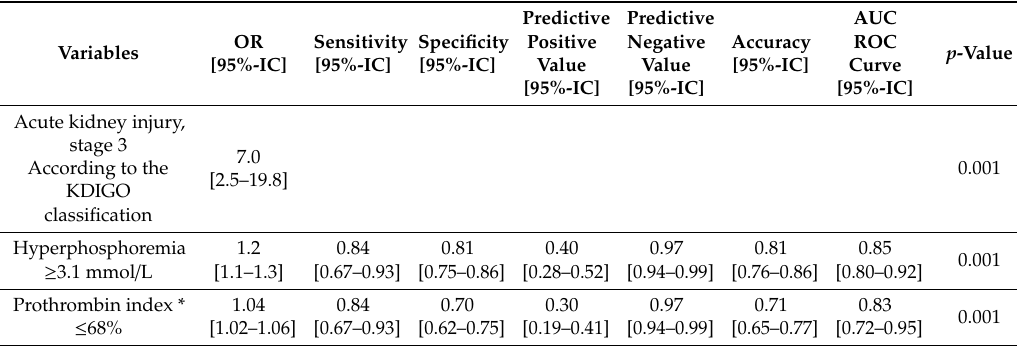
Table 9. Predictive factors of death on intensive care unit admission in the poisoned patient with rhabdomyolysis based on a multivariate logistic regression